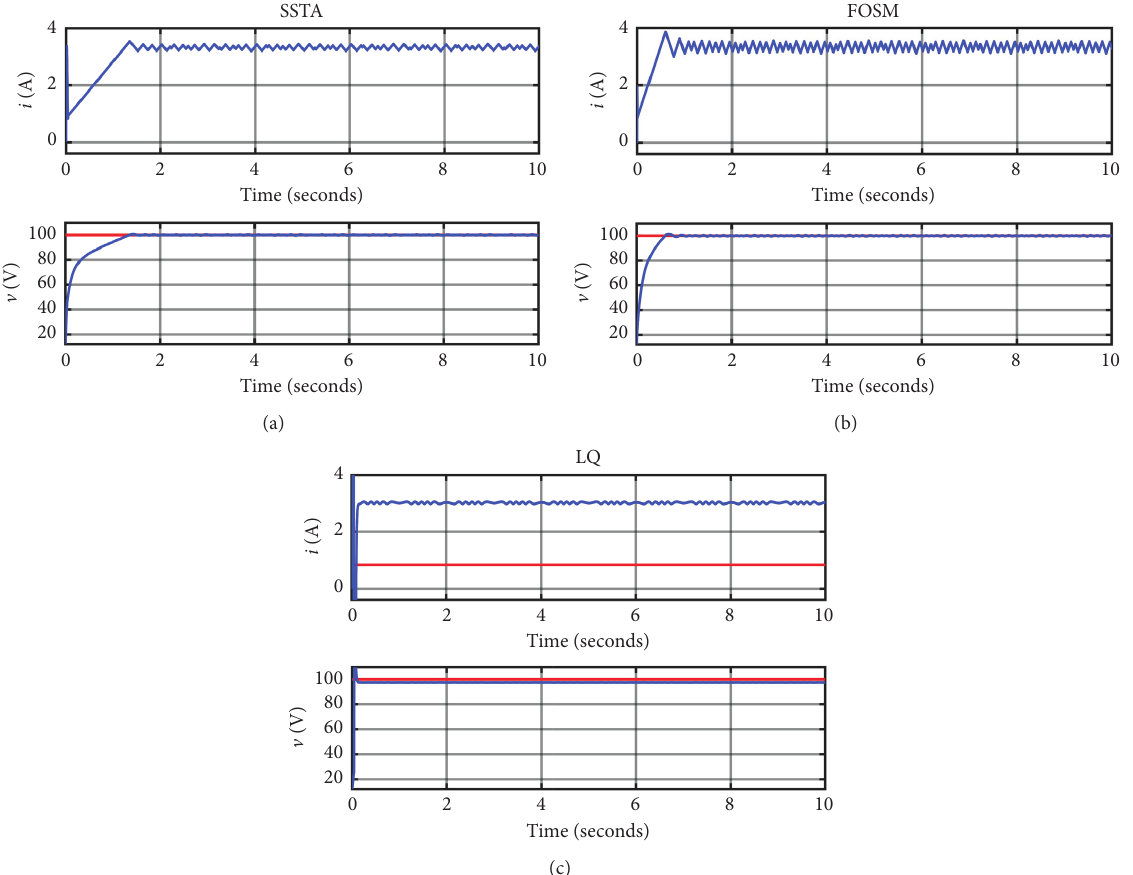
Figure 10: Voltage tracking (reference, red line and boost converter behavior, blue line). (a) SSTA controller. (b) FOSM controller. (c) LQ controller.